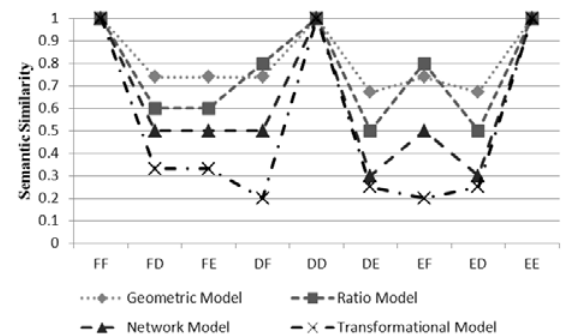
Figure 5 Semantic Similarity of Running Examples in different Models